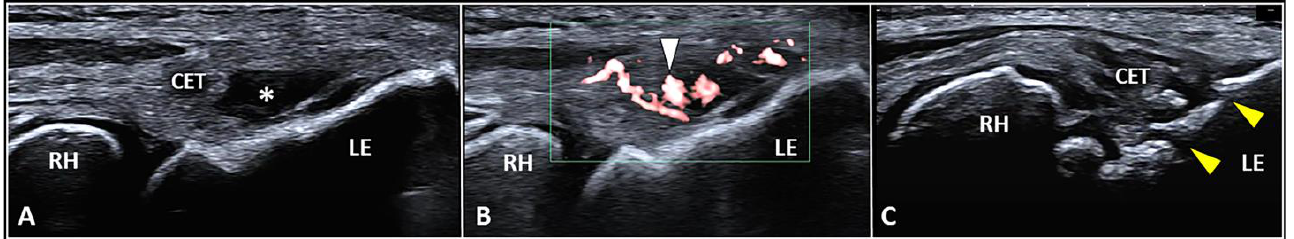
Figure 3. Partial tear ( white asterisk ) of the insertion zone of CET ( A ), focal tendinosis with inner hypervascularization ( white arrowhead ) ( B ), and enthesitis with cortical irregularities ( yellow arrowhead ) ( C ) of the lateral epicondyle ( LE ) should be considered among the most common sonographic findings related to the clinical picture of lateral epicondylitis. RH: radial head.